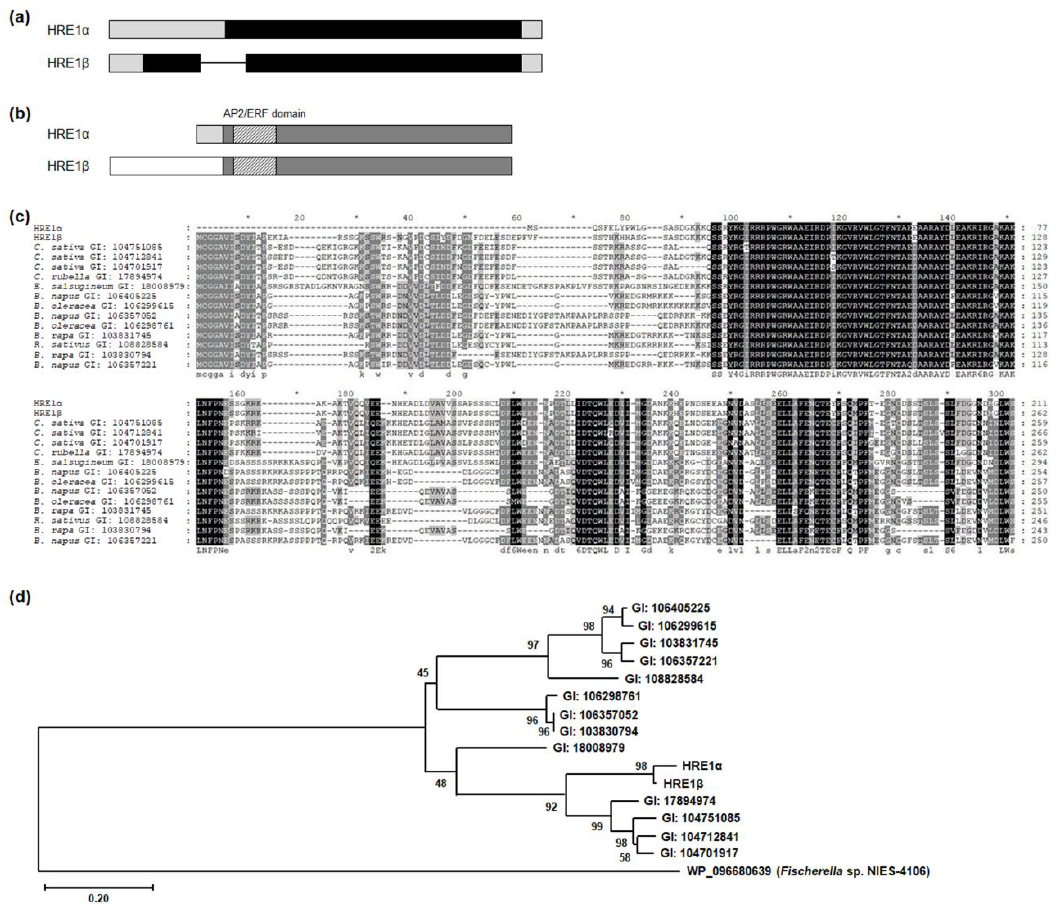
Figure 1. Splicing variant isoforms of HRE1. ( a ) The genomic structures of HRE1α and HRE1β . Black box, gray box, and line indicate coding region, untranslated region, and intron, respectively. ( b ) The protein domains of HRE1α and HRE1β. Dark gray box, light gray box, and white box indicate the common region of HRE1α and HRE1β, HRE1α-specific N-terminal region, and HRE1β-specific N-terminal region, respectively. Boxes with deviant crease line indicate the AP2/ERF domain. ( c ) Multiple alignment among HRE1α, HRE1β, and the orthologs of HRE1β in other plant species. Multiple alignment was performed with the amino acid sequences of the full-length ORFs of HRE1α,